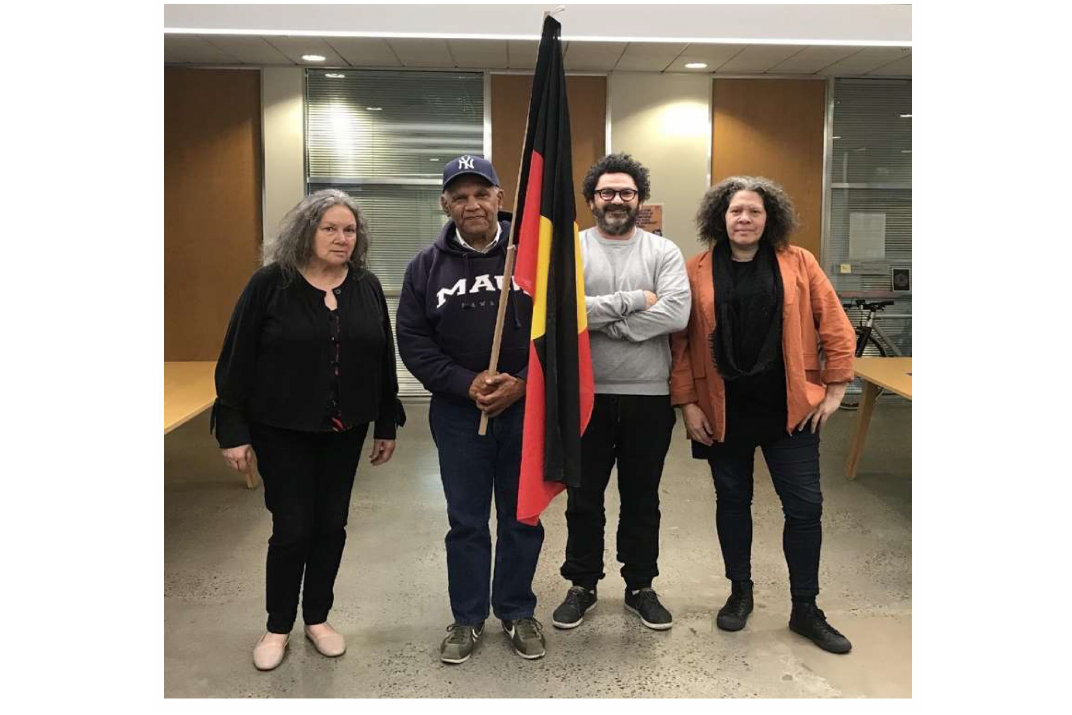
Figure 1. Aunty Rhonda Dixon-Grovenor, Uncle Jimmy Smith, Jason De Santolo and Nadeena Dixon on Gadigal Land in the UTS DAB Faculty Building during the pandemic (Source: photograph by Jason De